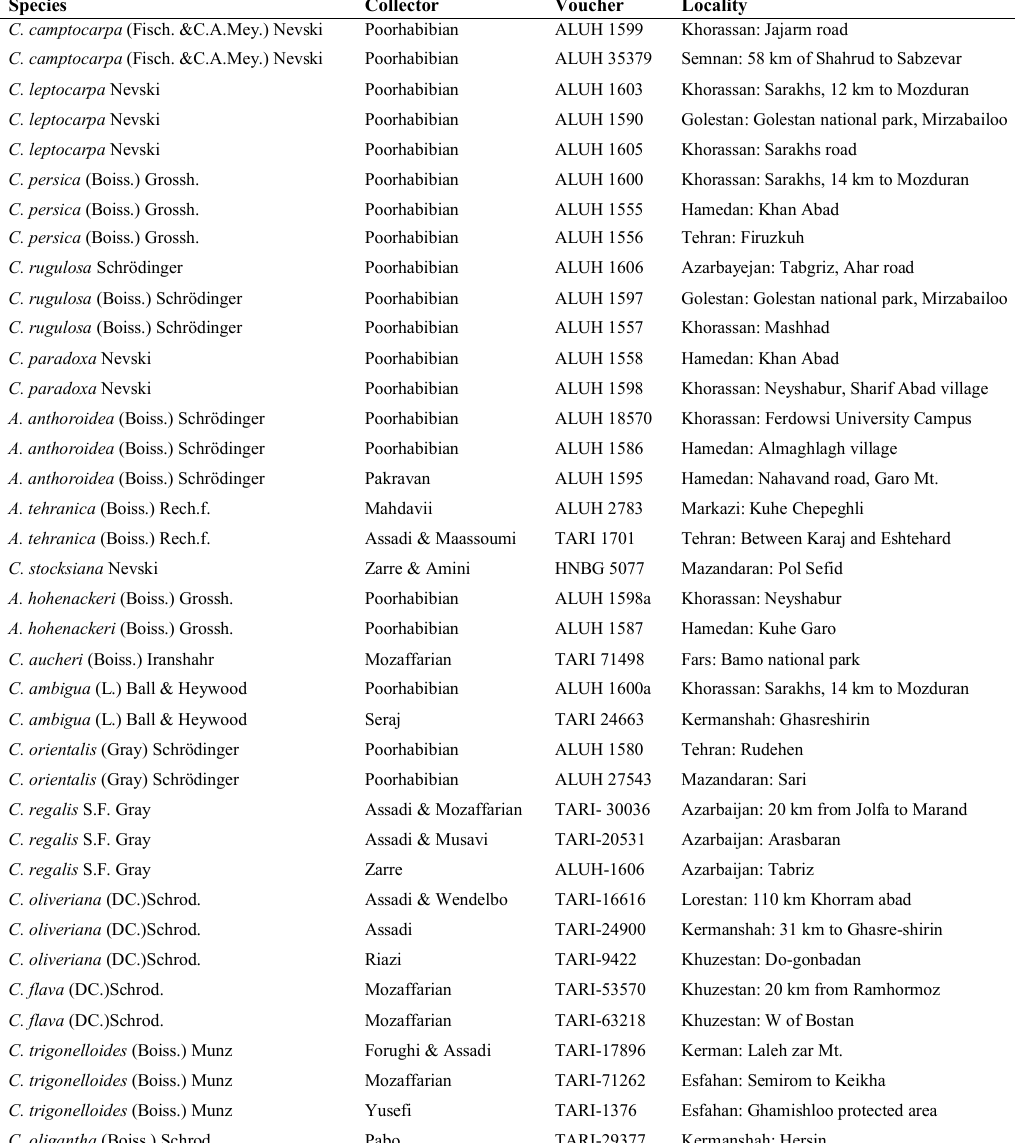
Table 2. List of species studied for phenetic, localities and voucher